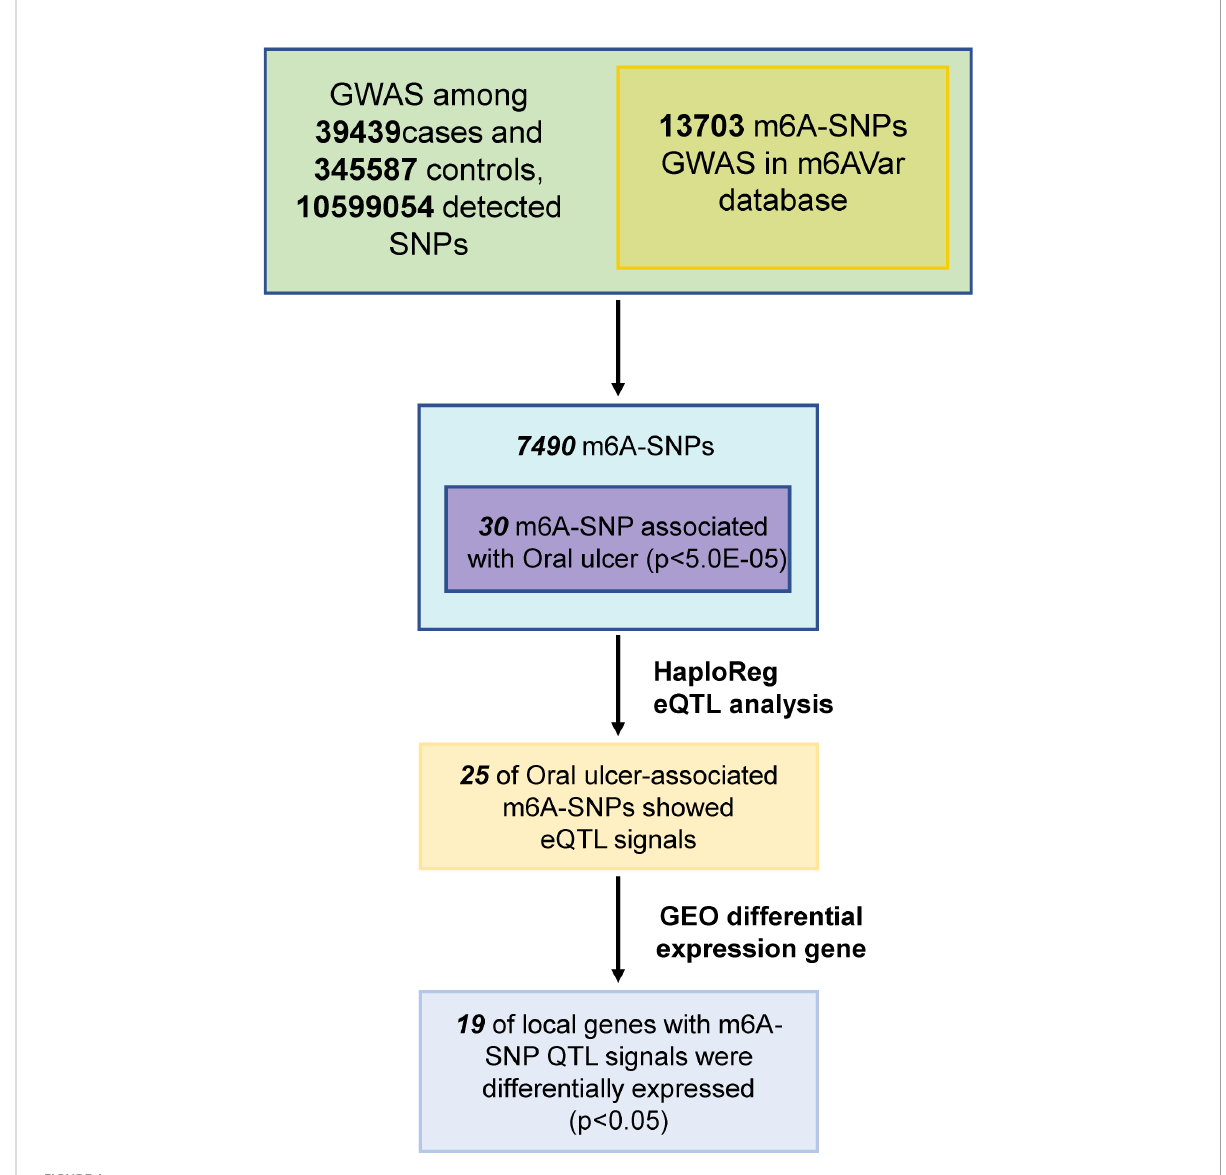
FIGURE 1 Flow chart of research designs and main